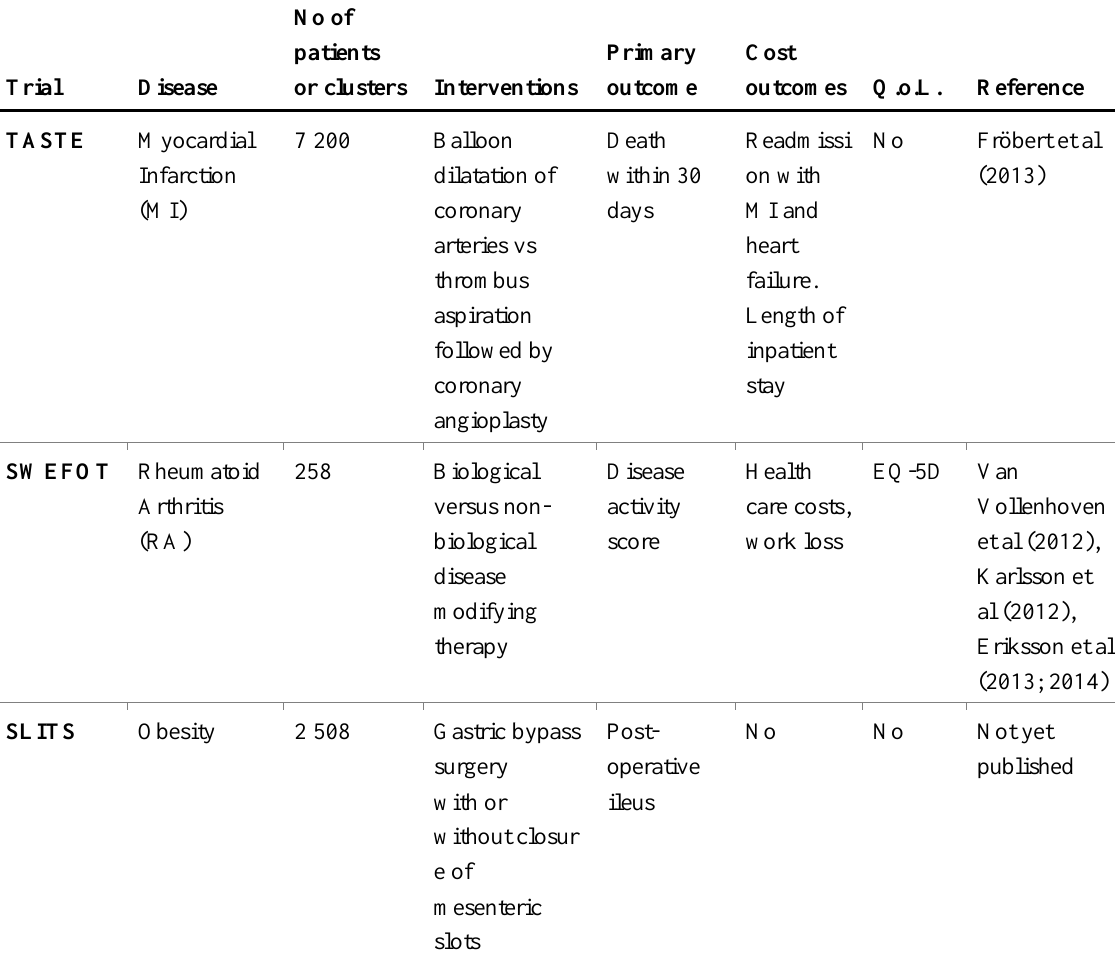
Pragmatic randomized trials in routine care with follow up in